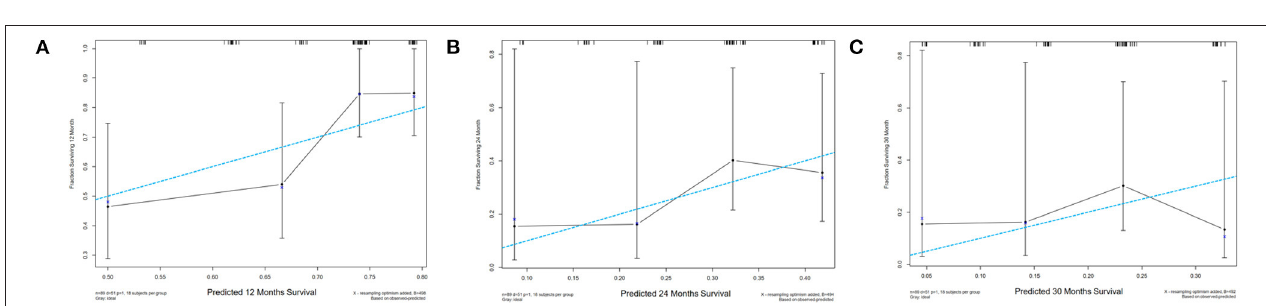
FIGURE 5 | Calibration plots of the nomogram for comparison of the predicted and actual observed overall survival (OS) in (A) 12-month, (B) 24-month, (C) 30-month. The X -axis was the predicted OS probability while the Y -axis was the observed probability. The vertical bars indicate 95% CIs. The dashed line of dashes indicates a perfect model while the solid line indicates the actual predicted model. OS, overall